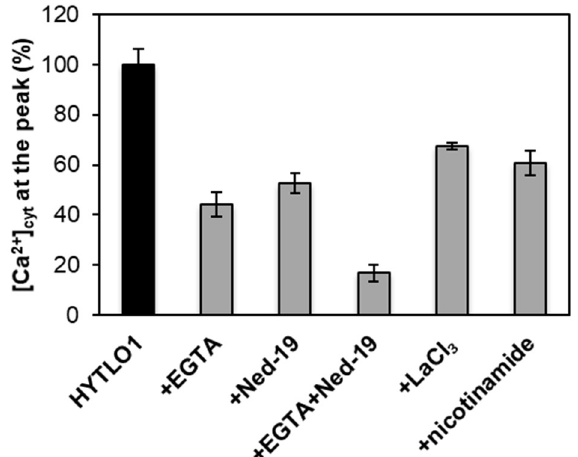
Figure 4. Pharmacological approach for the analysis of cytosolic Ca 2+ fluxes induced by HYTLO1 in L. japonicus cells. Cell samples were incubated with: EGTA (600 µ M), Ned-19 (100 µ M) (singly or in combination with EGTA), LaCl 3 (3 mM), nicotinamide (100 µ M). After 10 min (EGTA, LaCl 3 , nicotinamide) or 30 min (Ned-19), cells were challenged with HYTLO1 (0.6 µ M). For assays performed with EGTA, cells were previously washed extensively and resuspended in Ca 2+ -free medium. Data are the means ± SE of five independent experiments.